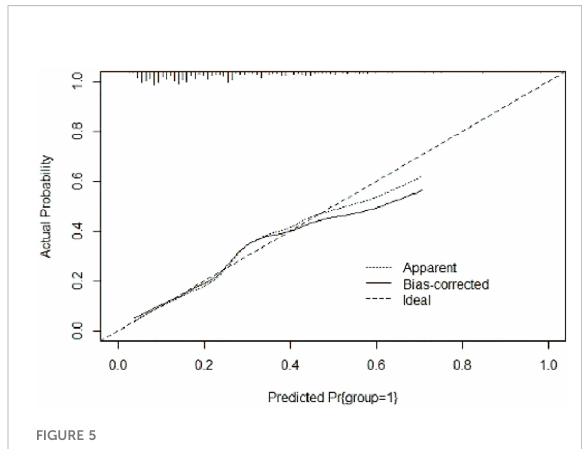
FIGURE 5 Calibration curve of the risk nomogram model for the prediction of bile duct injuries after DEB-TACE in patients with HCC.